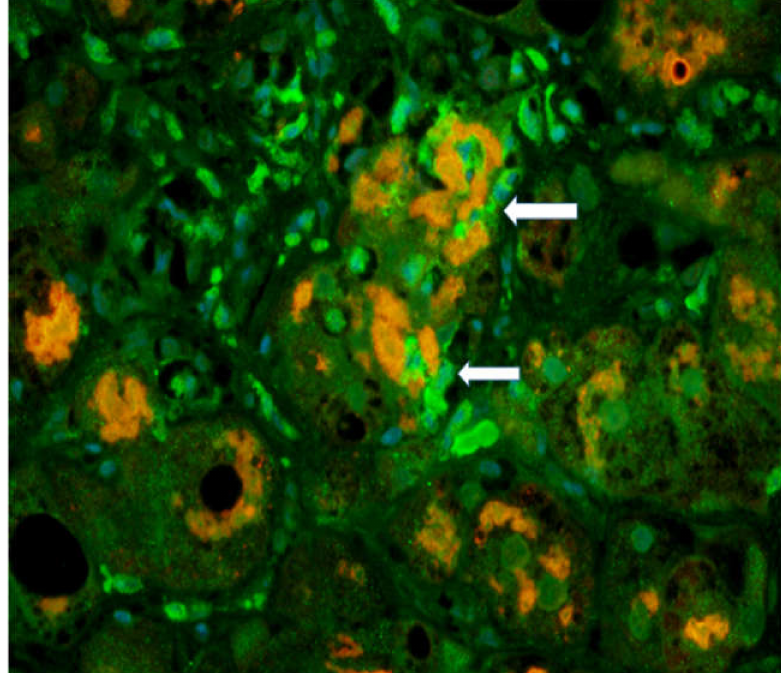
Figure 1. Immunofluorescent (IHC) staining of polymorpho-neutrophil cells (PMN)s with a GNA15 antibody showing neutrophils (arrows) (green) and Mallory Denk Bodies (orange stain) showing satellitosis × 200. Original figure is adapted from (Luo C, et al. 2018. Exp Cell Res 365: 1-11). No copywritting permission is